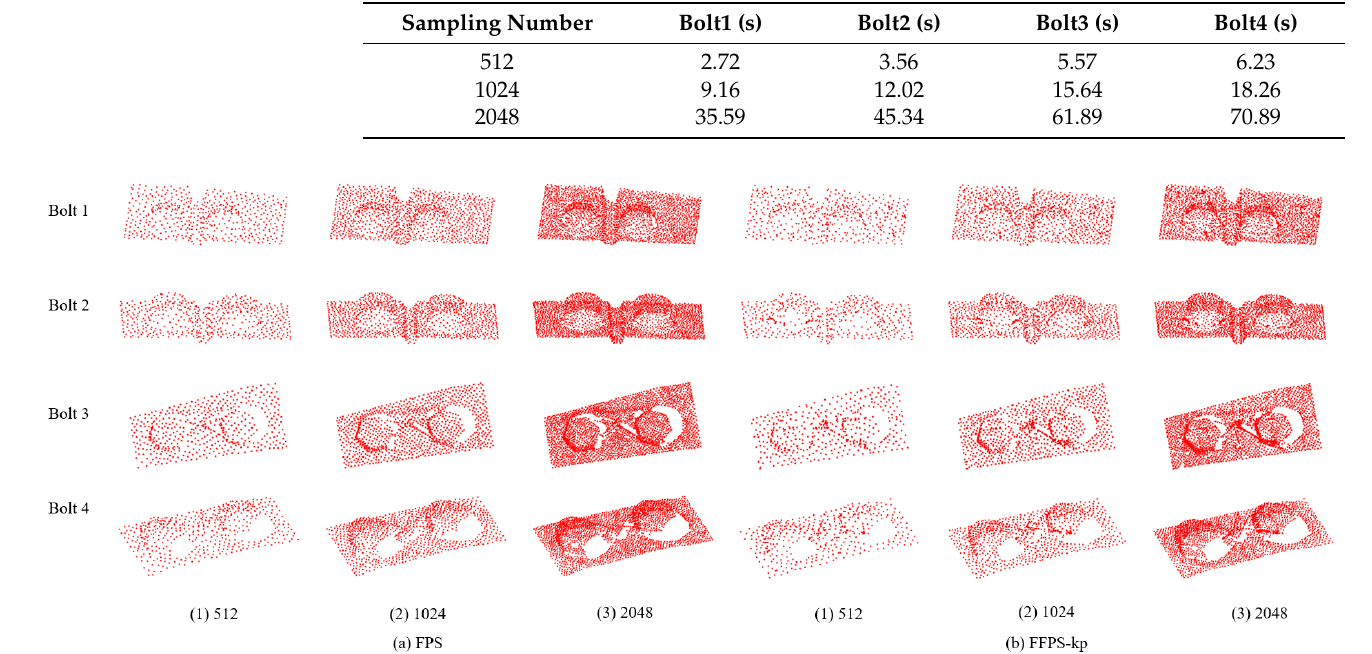
Figure 7. Comparison results of the sampling.